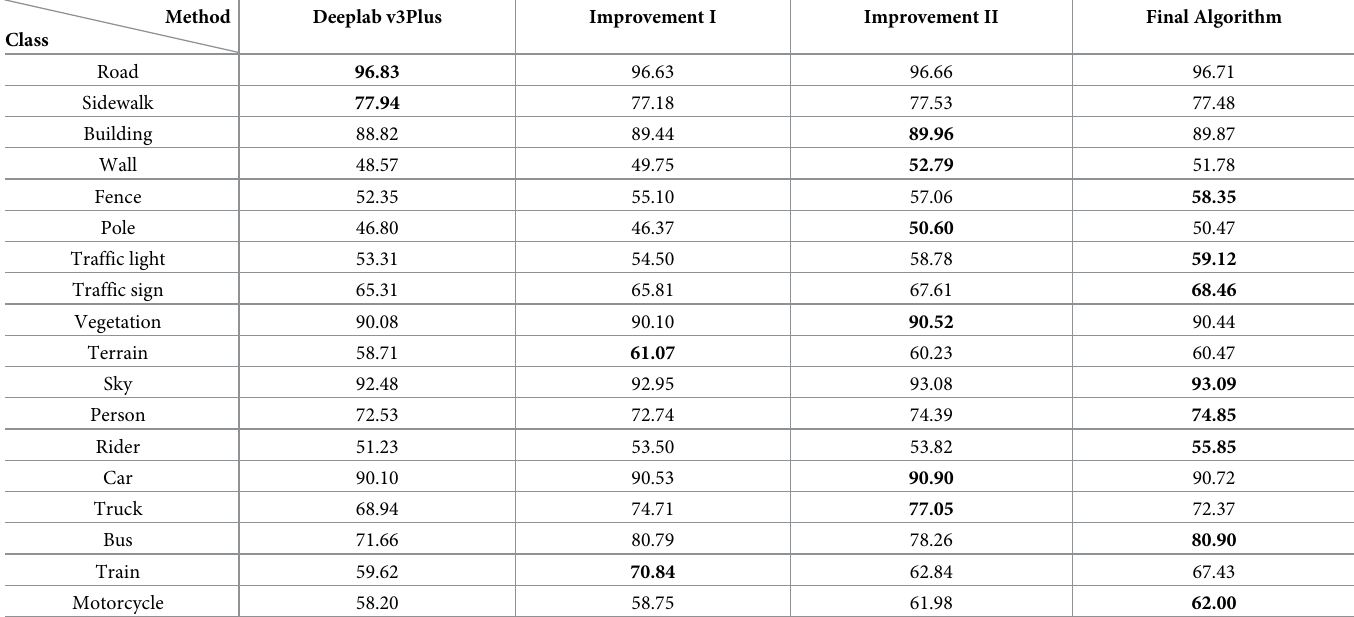
Table 3. Segmentation results of Cityscapes dataset experiment (unit: %).